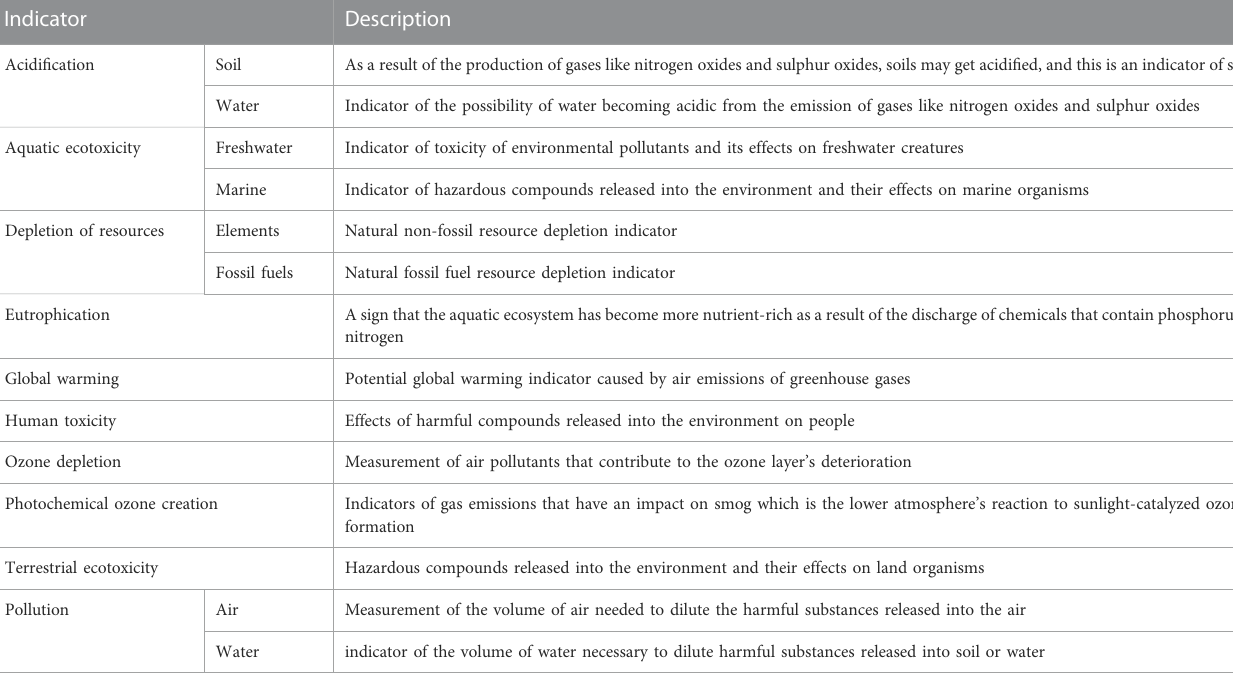
TABLE 1 Impact categories and criteria in environmental life cycle assessment (Kumar et al., 2020b).